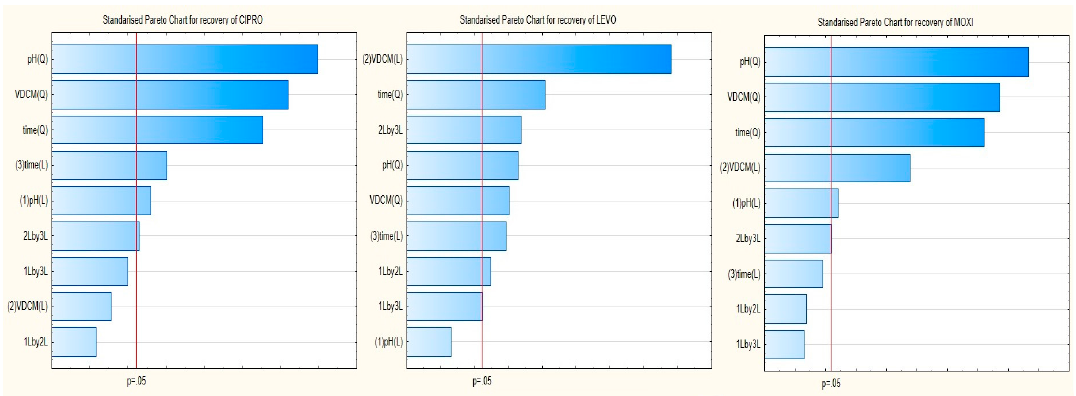
Figure 1. Standardized Pareto charts for recovery of CIPRO, LEVO and MOXI.